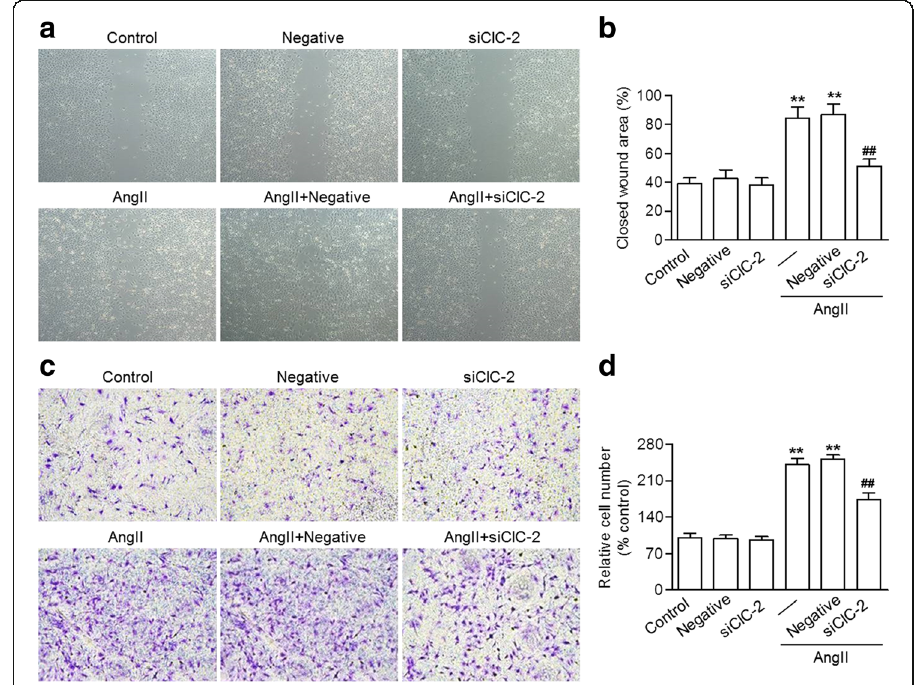
Fig. 3 ClC-2 downregulation prevented AngII-induced HBVSMC migration and invasion. a HBVSMCs transfected with ClC-2 siRNA (siClC-2; 20 nM) or negative siRNA (negative; 20 nM) were subjected to angiotensin II (AngII) treatment (10 − 7 M). The wound healing assay was performed. Representative images are shown (× 100). b The quantification results for the wound closure. c HBVSMC migration was examined via transwell analysis. Representative images are shown (× 100). d The columns represent the relative numbers of invasive cells. ** p < 0.01 vs. control, ## p < 0.01 vs. AngII alone, n =